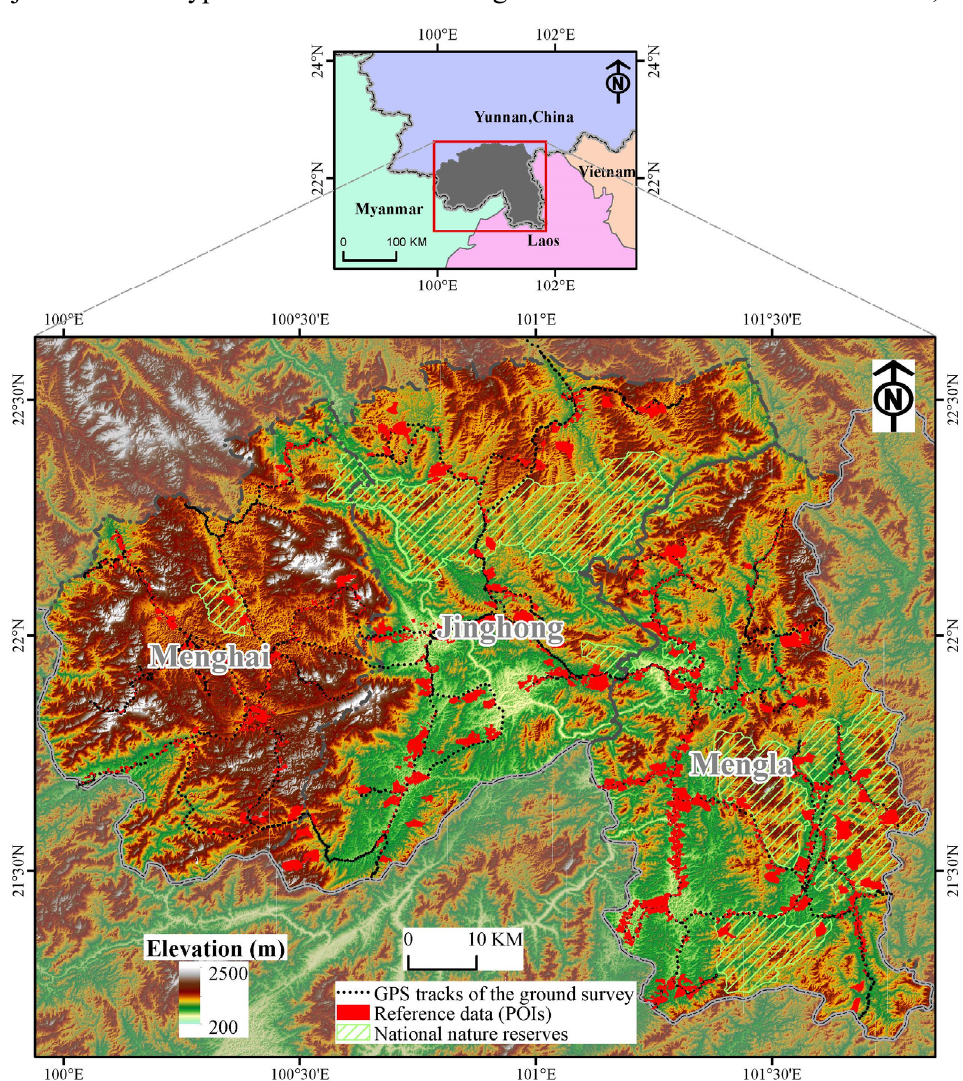
Figure 1. Topography of the study area. The black dotted lines show the GPS tracks of the field trips between September and November of 2014. The red polygons denote the polygons of interest (POIs) for the validation of the resulting rubber plantation